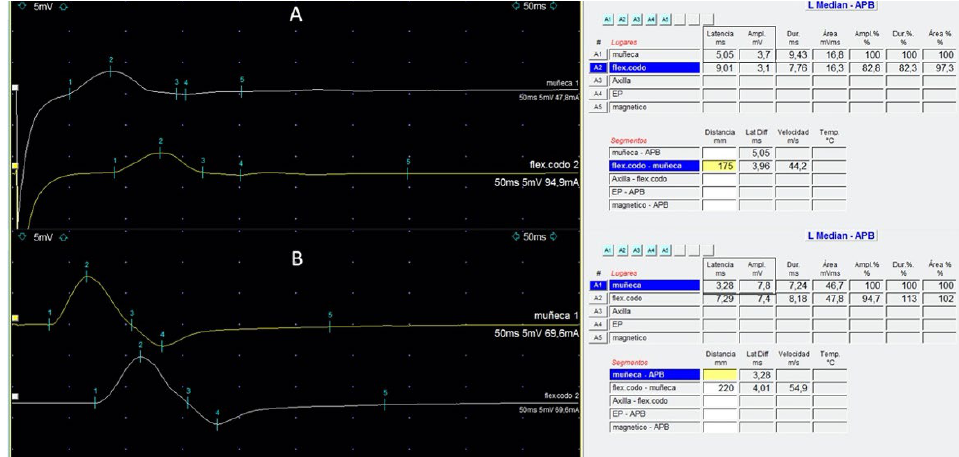
Figure 1. Left median motor nerve conduction studies at wrist (upper trace) and elbow (lower trace) in a patient with HL that developed grade-3 BVIN ( A ) and at recovery ( B ), 6 months later. The presence of delayed distal latencies (square in ( A )) (normal < 3.9 ms); reduced CMAP amplitude (square in (A)) (normal > 6 mV) with preserved middle segment velocities, representing features of an acquired peripheral neuropathy with distal demyelination. Normalisation of distal latency and CMAP can be observed at recovery ( B ).